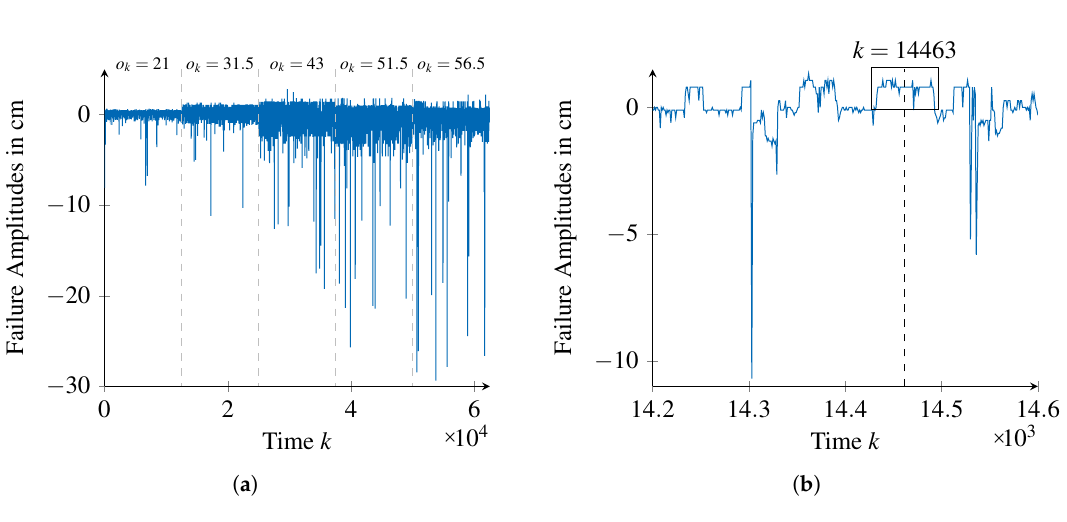
Figure 11. Failure amplitudes from the Sharp GP2D12 infra-red distance sensor. ( a ) complete series of failure amplitudes; ( b ) segment of the failure amplitudes for reference distance o k “ 31.5